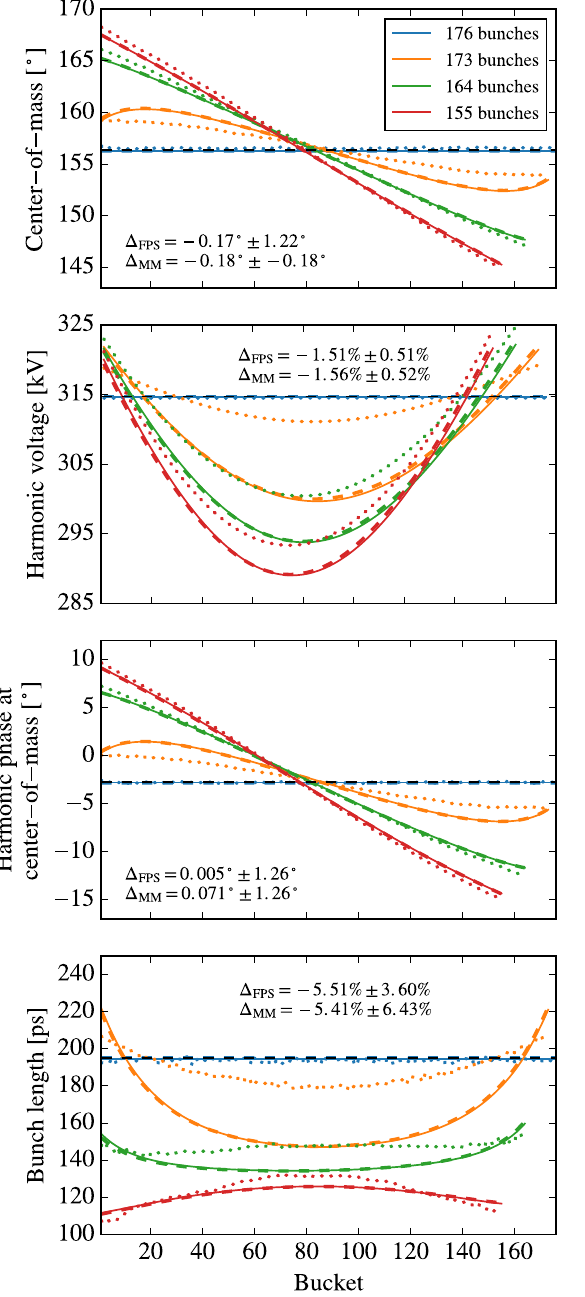
FIG. 5. Center-of-mass, harmonic field and bunch length for different gaps including scalar form factor for the matrix formulation (solid) and F ILL P ATTERN S IM (dashed). The MBTRACK results (dotted) and the analytical values for a uniform fill pattern (black dashed) are shown for comparison. The mean and RMS of the deviations from the MBTRACK results are displayed for the case with 164 bunches.